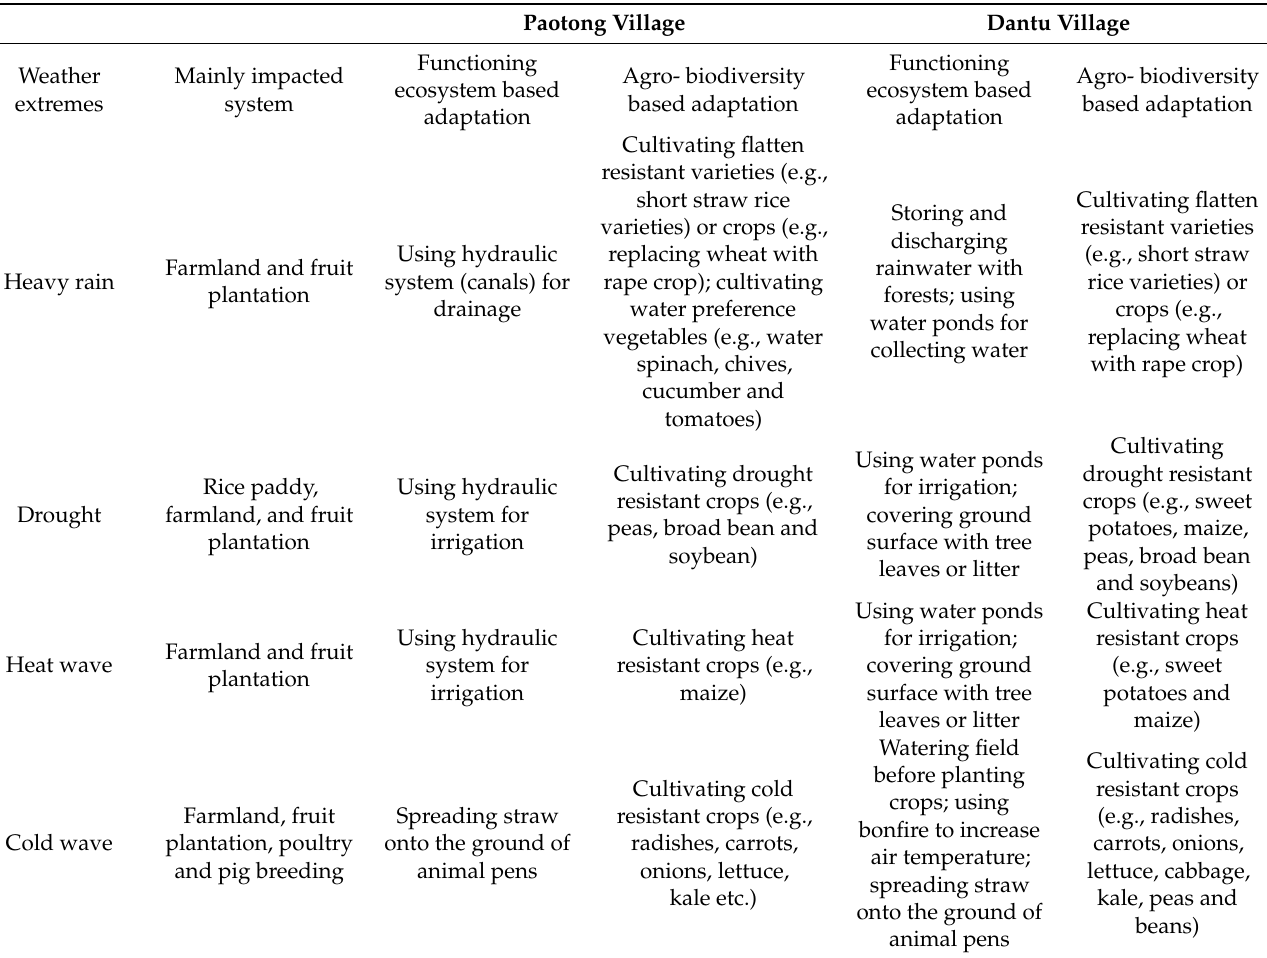
Table 4. EbA strategies to cope with weather extremes in the two villages. Paotong